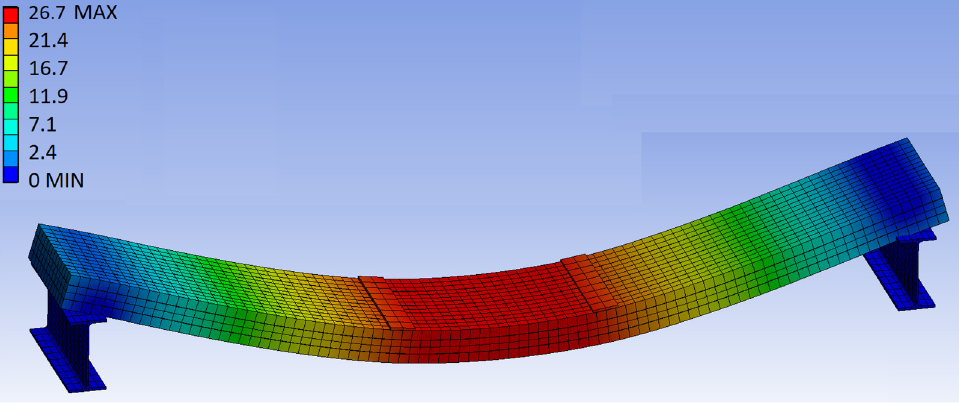
Figure 10. Deflection contour of the numerical model in ANSYS Workbench (values in (mm)). Figure 11 shows the longitudinal normal stress contour corresponding to 40% of the estimated maximum force. It can be seen that the progress of stress corresponds to the stiffness of the individual layers in the longitudinal direction.